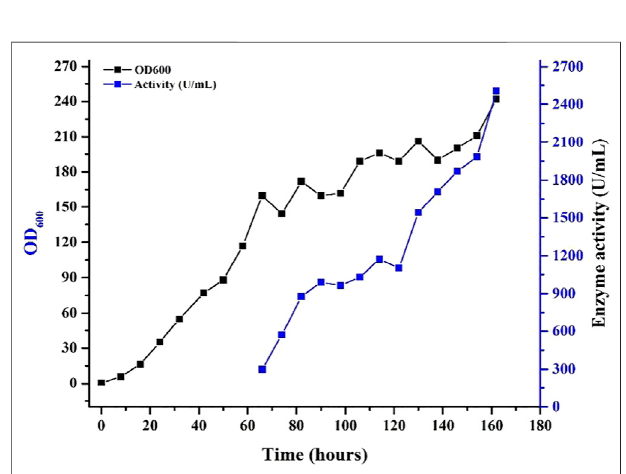
FIGURE 3 | Expression of the recombinant Mtxyn11C in a 7.5 L fermentor for xylanase